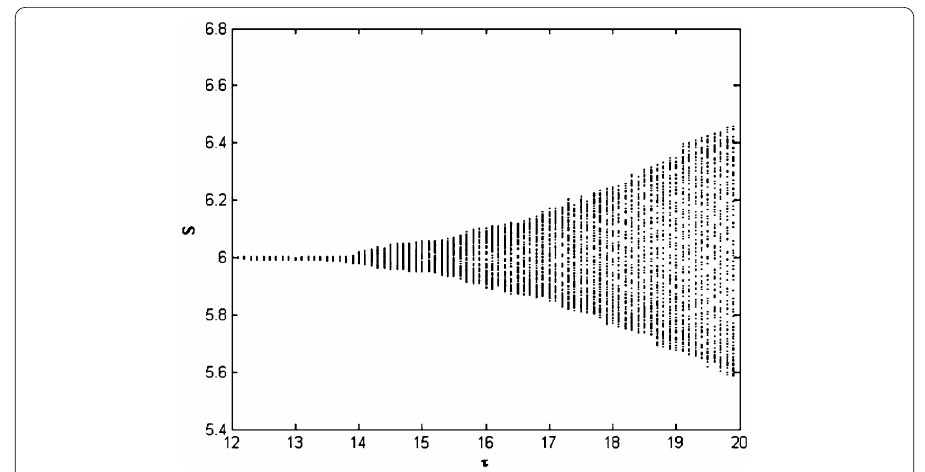
Figure 8 Bifurcation diagram with respect to time